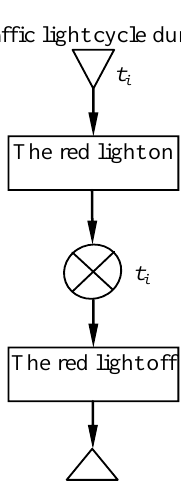
Figure 2: Light cycle